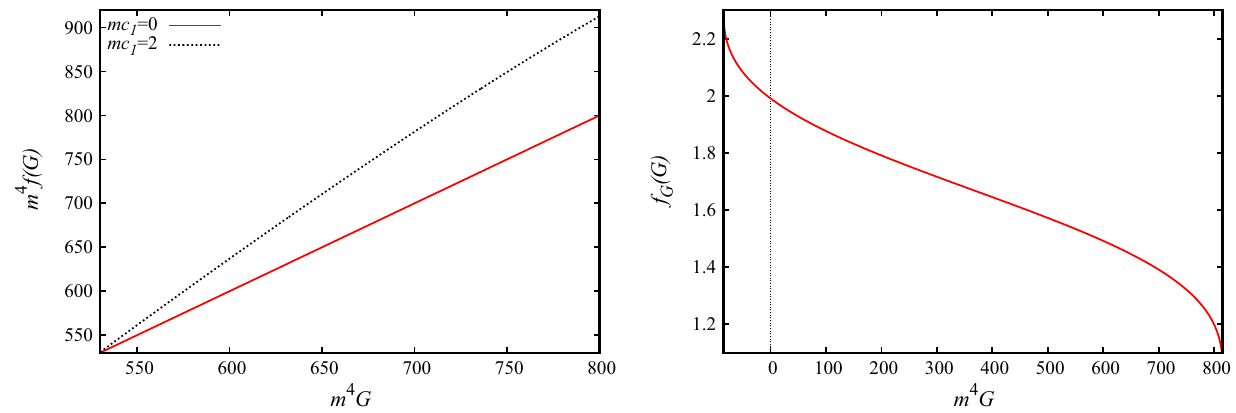
Fig. 8 Graphical representation for the functions f G ( G ) and f ( G ) in terms of the Gauss–Bonnet invariant with q = 0 . 7 m , c 0 = 1, mc 1 = 0 , 2 for f ( G ) and mc 1 = 2 for f G ( G